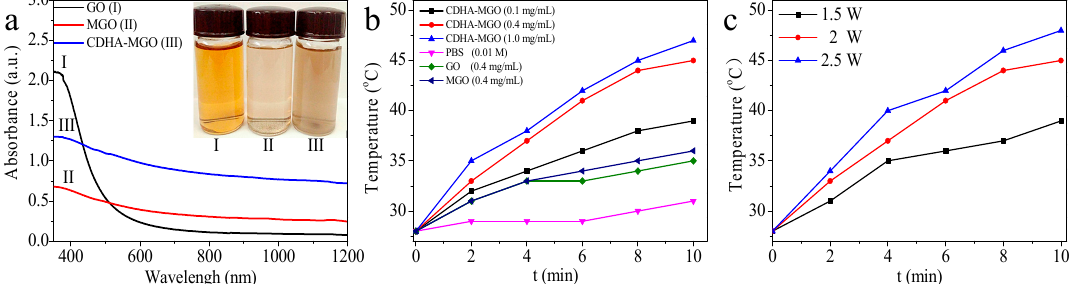
Figure 4. ( a ) UV-Vis-near-infrared (NIR) absorption spectrum and photograph (insert) of 0.25 mg/mL GO (I), MGO (II) and CDHA–MGO (III) solutions. ( b ) Photothermal heating curves of GO, MGO, and CDHA–MGO solution (PBS, pH 7.4) irradiated by NIR light at 2 W · cm − 2 . The concentrations of the GO and MGO solutions are 0.4 mg/mL, and the concentrations of the CDHA–MGO solutions are 0.1, 0.4, and 1 mg/mL; ( c ) photothermal heating curves of CDHA–MGO (0.4 mg/mL) at various NIR power intensities.